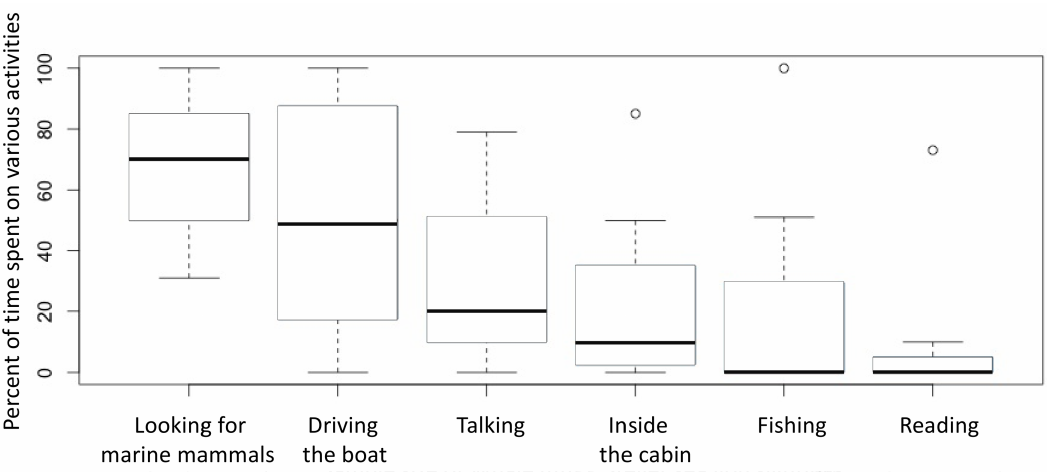
Figure 5. Percent of time citizen scientists spent doing various activities while using Whale